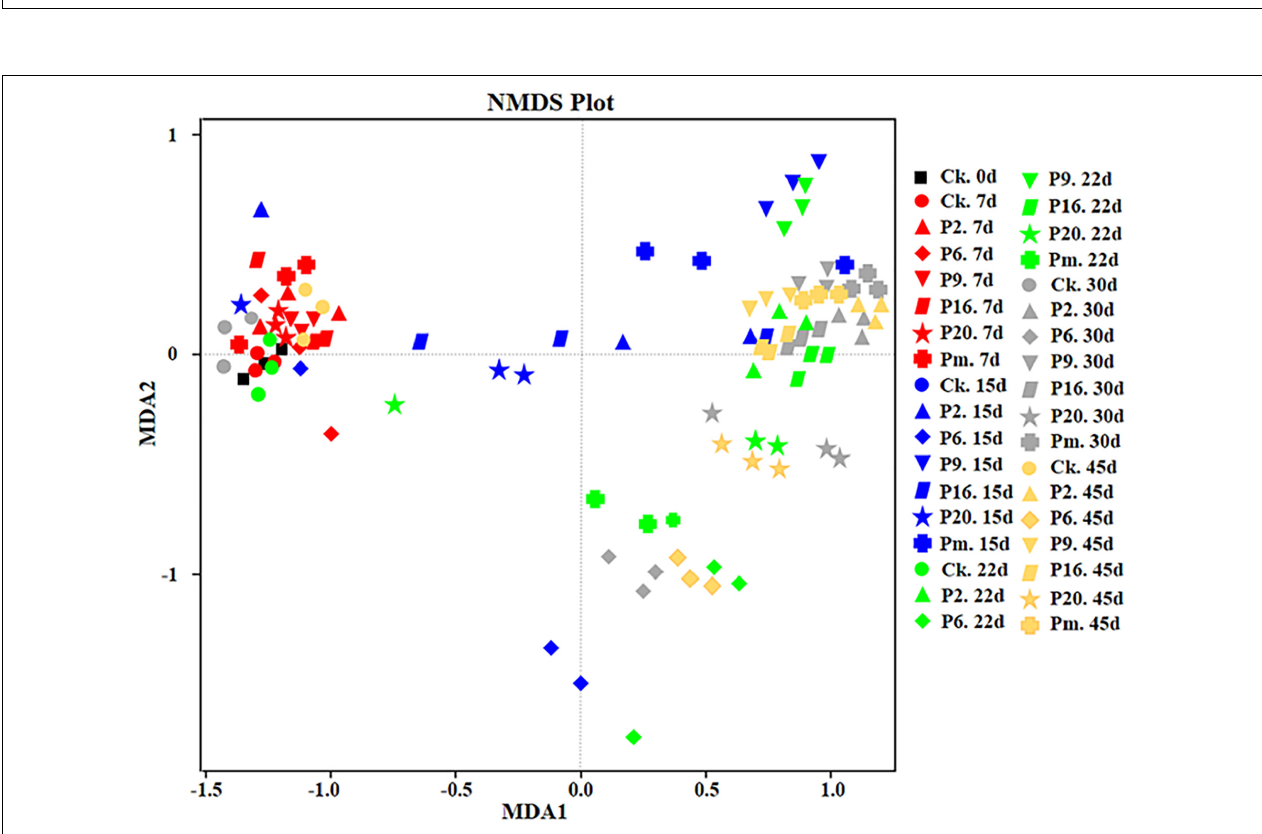
FIGURE 6 | Non-metric multi-dimensional scaling analysis of the bacterial community structure of bacon inoculated with potential spoilage bacteria. The analysis was based on the relative abundances of all genera of microbiota detected by high-throughput sequencing. CK, Control; P2, Staphylococcus xylosus ; P6, Leuconostoc mesenteroides ; P9, Carnobacterium maltaromaticum ; P16, Leuconostoc gelidum ; P20, Serratia liquefaciens ; Pm, The five strains in combination.